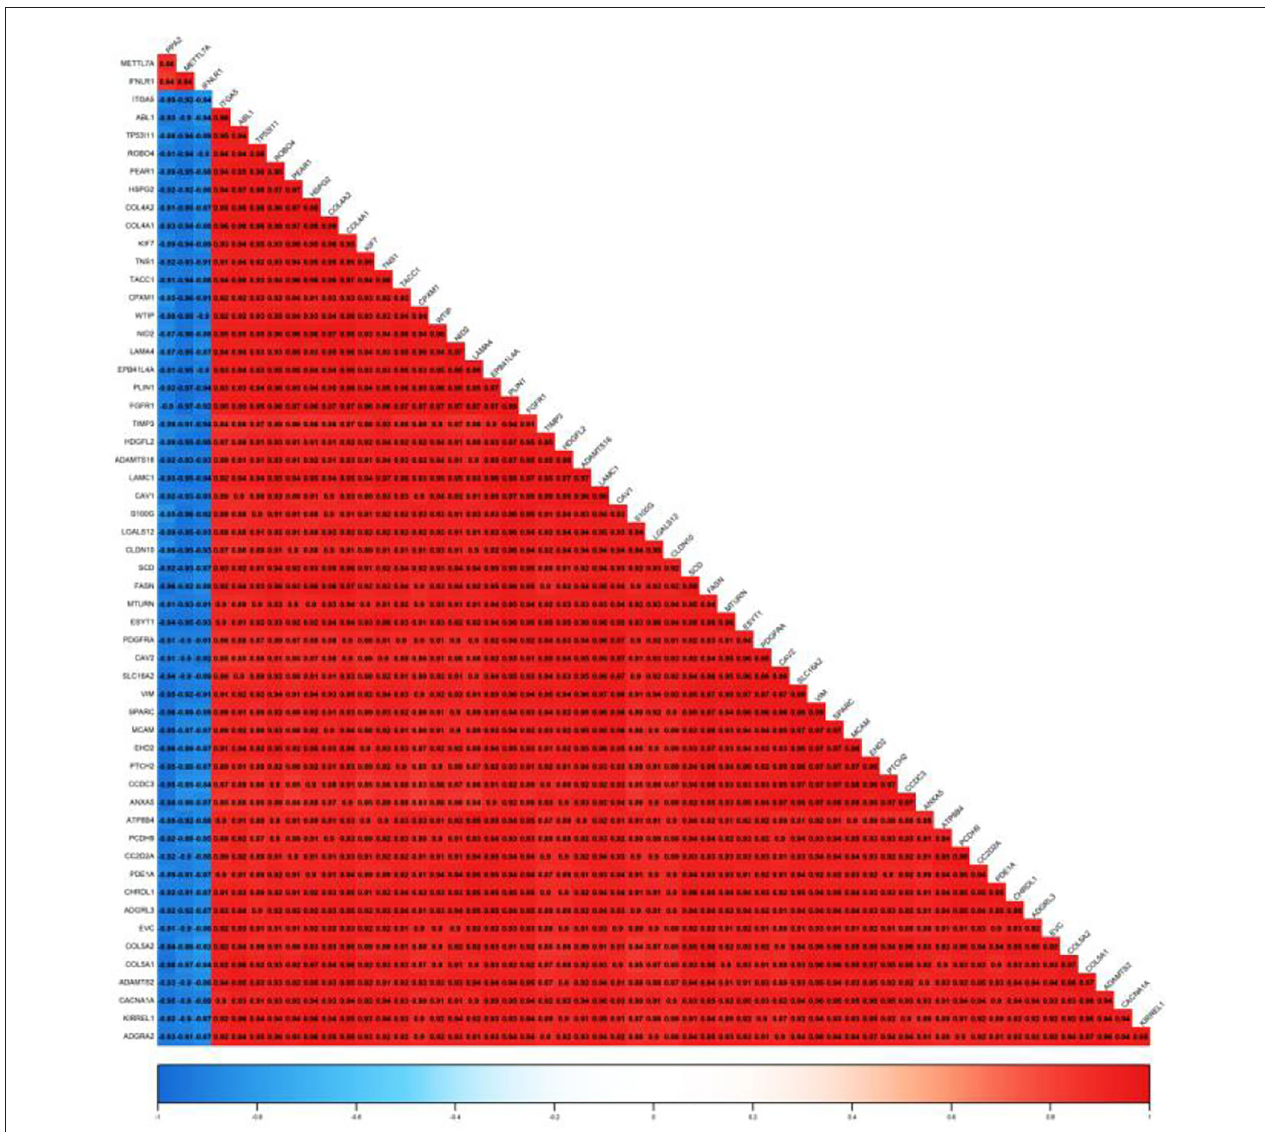
FIGURE 5 | Correlation of the top 56 genes with high MM and GS in the blue